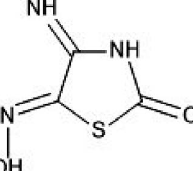
Fig 1. Structural formula of the HITO.